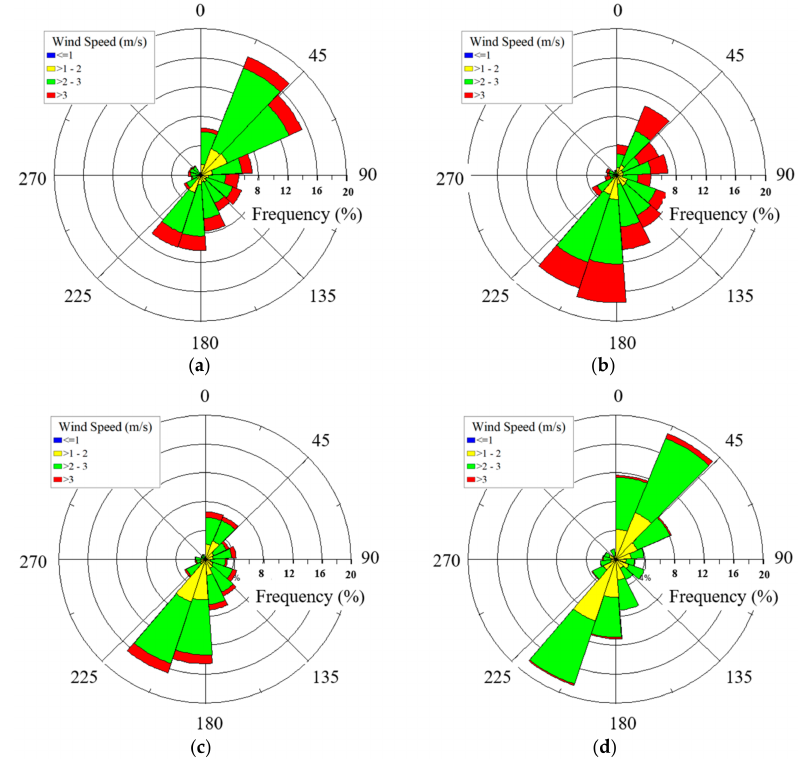
Figure 9. Seasonal wind rose plots at the test site using all predicted wind data: ( a ) Winter; ( b ) Spring; ( c ) Summer; ( d )